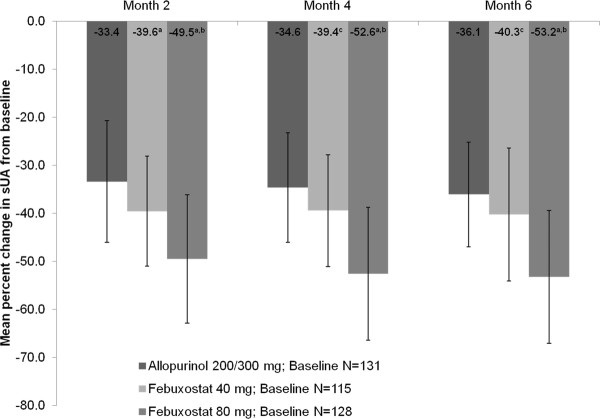
Mean Percent Change From Baseline In Serum Urate at Each Scheduled Visit. ap < 0.001 vs allopurinol; bp < 0.001 vs febuxostat 40 mg; cp ≤ 0.027 vs allopurinol. Error bars represent standard deviation.